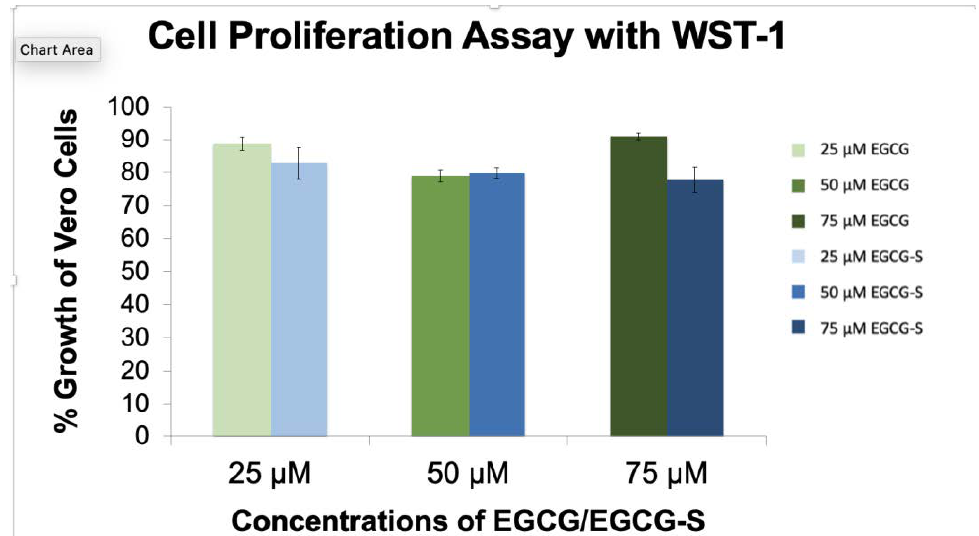
Figure 1. Cell viability assay with EGCG and EGCG-S. Vero cells were cultured in 6-well plates and treated with 25, 50, and 75 µM concentrations of EGCG and EGCG-S, respectively for one hour. DMSO and ethanol were used to determine their effect on Vero cells. The percentage of Vero cell viability was determined by using Trypan blue.